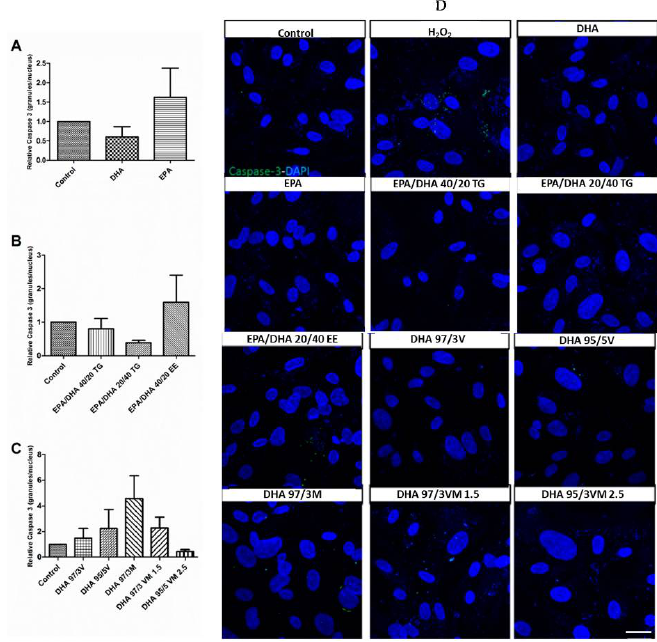
Figure 5. Graphs showing relative caspase-3 expression (positive granules per nucleus) ( A–C )